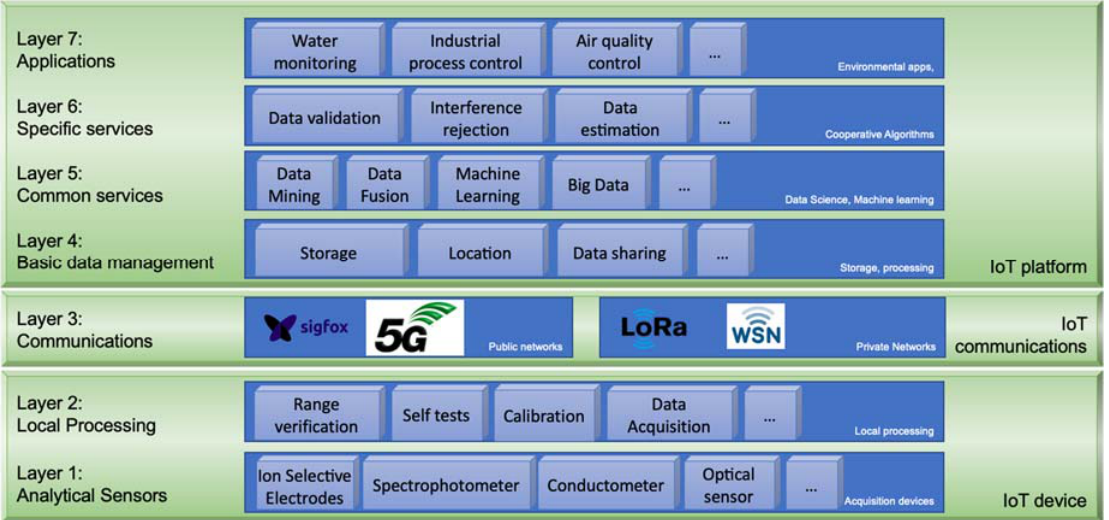
Figure 1. IoT services used in Analytical Chemistry and the relationships between